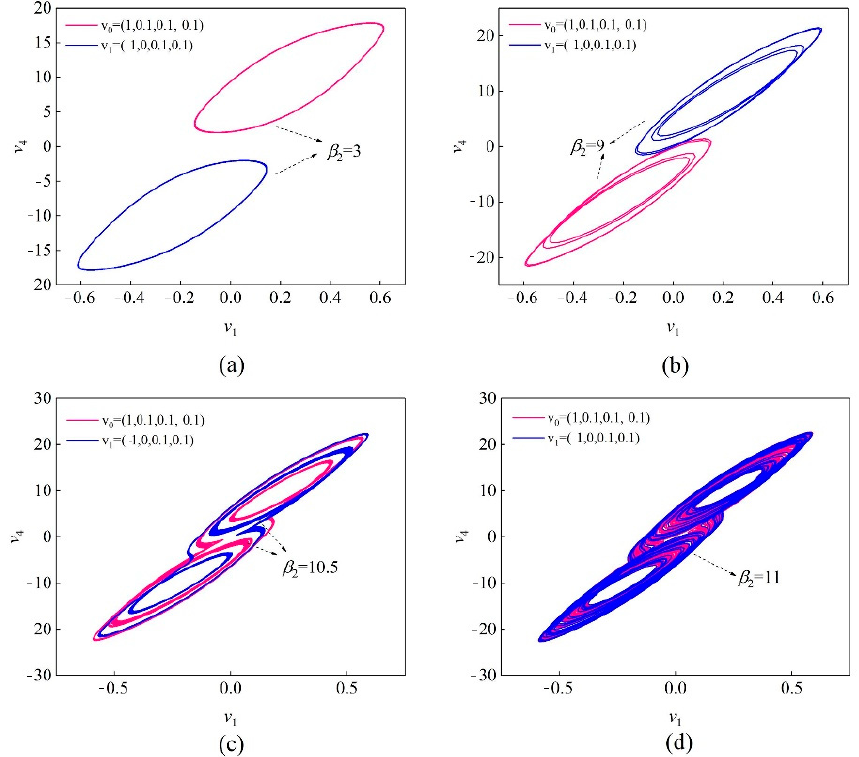
Figure 10. Attractor coexistence on the v 1 – v 4 phase plane with ( a ) β 2 = 3; ( b ) β 2 = 9; ( c ) β 2 = 10.5; ( d ) β 2 = 11.